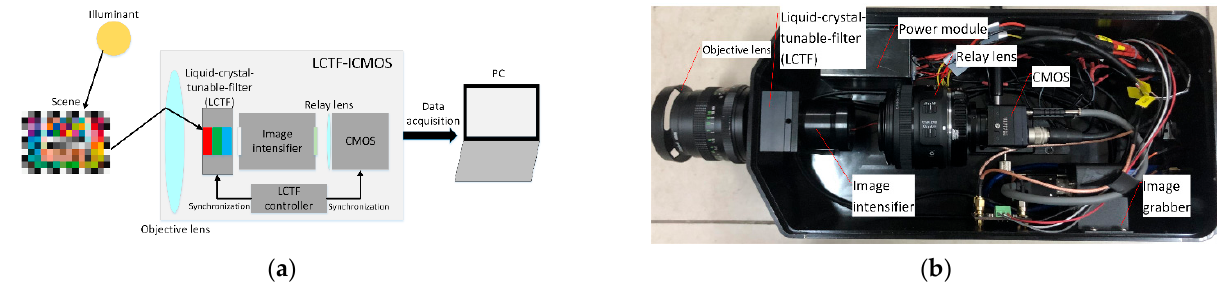
Figure 8. LCTF-ICMOS color imaging system: ( a ) imaging process of the system; ( b ) system setup with shell opened.